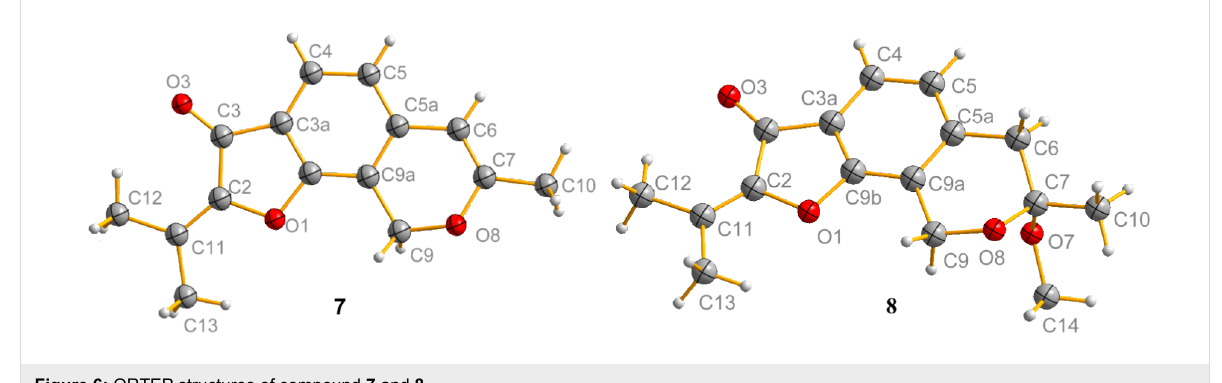
Figure 6: ORTEP structures of compound 7 and 8